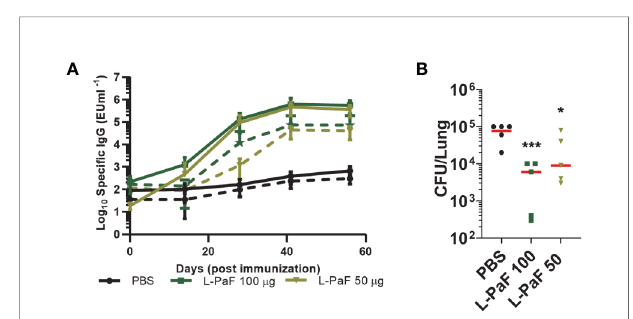
FIGURE 13 | Kinetics of IgG/IgA titers and protective ef fi cacy of LTA1- GSAAS-PaF (L-PaF) in rats. Rats were vaccinated three time by the IN route (Days 0, 14 and 28). Blood samples were collected and serum was separated. (A) IgG (solid lines)/IgA (broken lines) antibodies speci fi c for PcrV or PopB were measured by ELISA. The individual titers are represented as EU ml -1 , and each point represents mean ± S.D. of 10 mice per group. Statistical signi fi cance was calculated by comparing L-PaF 100 and 50 to PBS groups using a one-way ANOVA. (B) These rats were challenged IN on day 56 for comparison with PBS vaccinated mice. Statistical signi fi cance was calculated by comparing L-PaF 100 µg or L-PaF 50 µg to PBS immunized group using a one-way ANOVA. *p < 0.05; ***p <